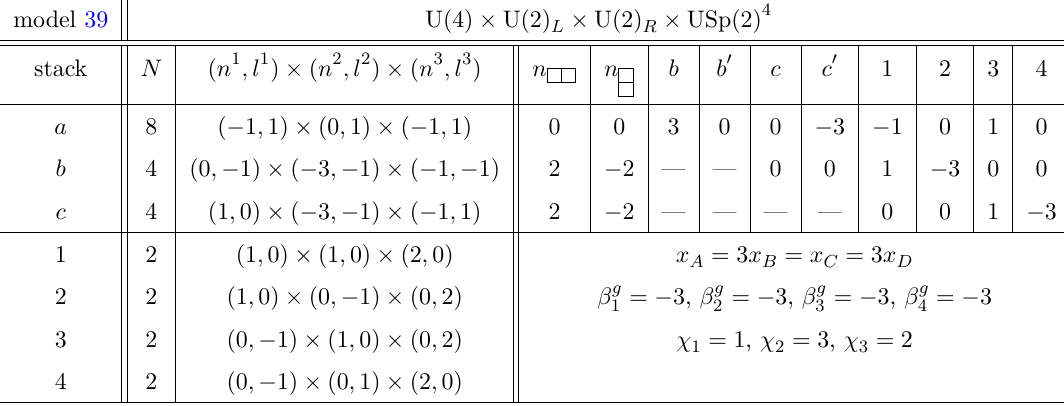
Table 39 . D6-brane configurations and intersection numbers of Model 39, and its MSSM